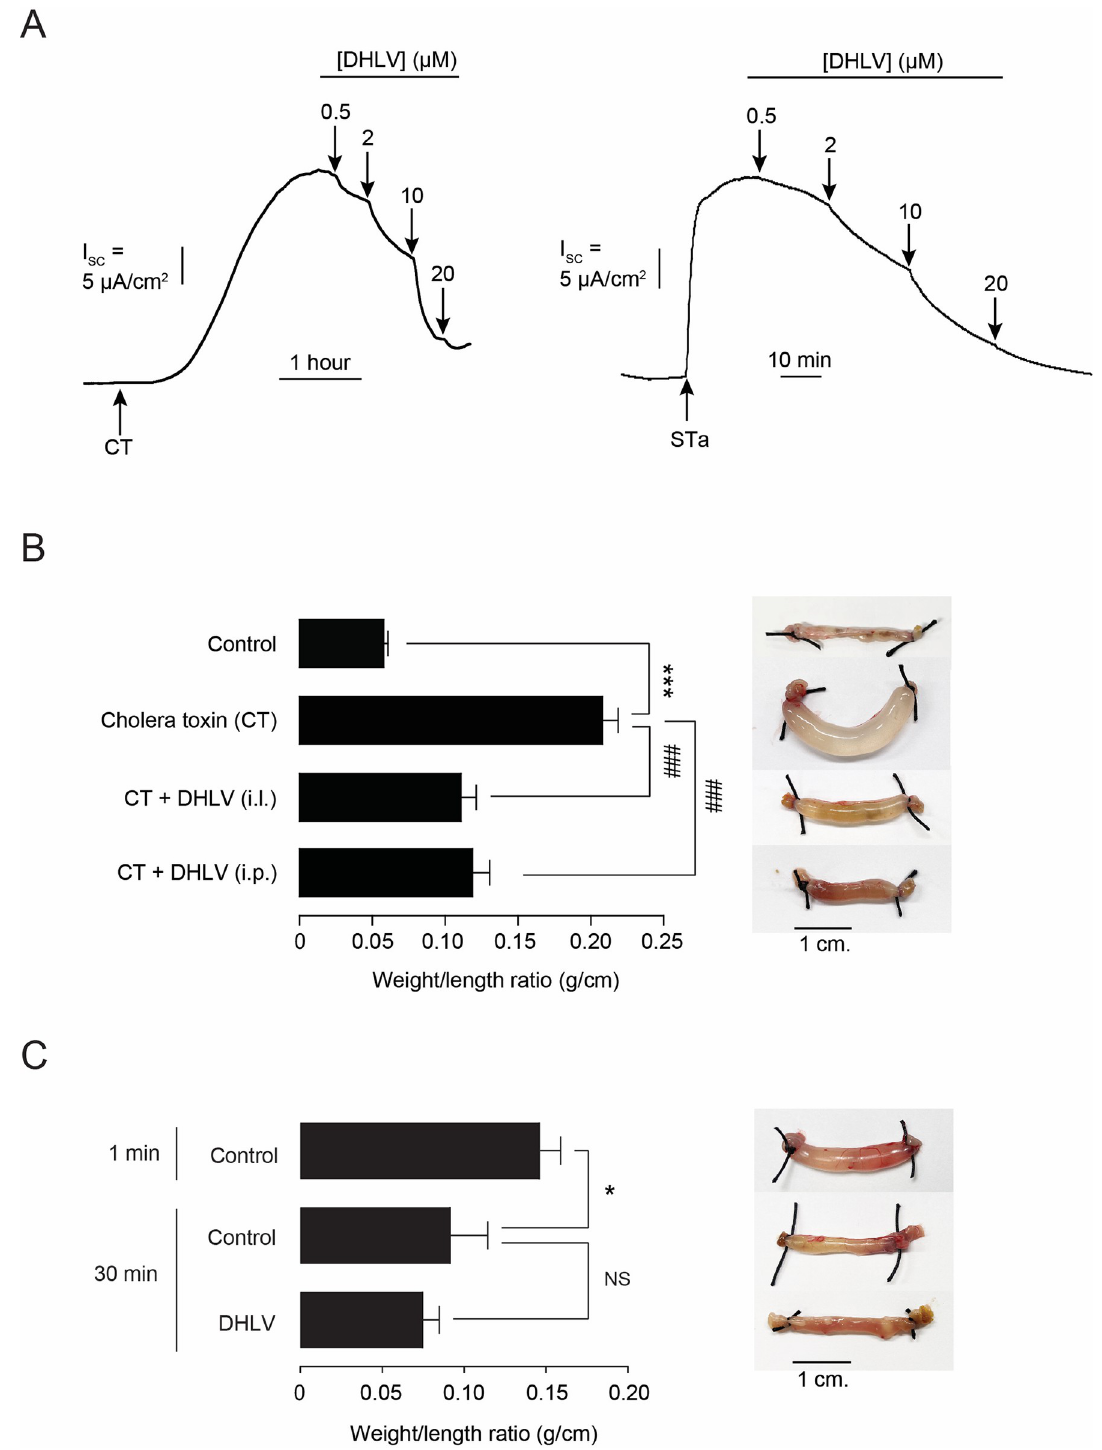
Fig 7. Potential utility of α , β -dehydrolovastatin (DHLV) as an anti-diarrheal agent for secretory diarrheas. (A) Effect of DHLV on cholera toxin (CT)- and heat-stable toxin (STa)-stimulated Cl - secretion in T84 cell monolayers determined by I SC analysis. After apical addition of CT (1 μ g/ml) or STa (100 μ M) to stimulate the increasing of I SC , DHLV was added in both apical and basolateral solution. Representative I SC tracings are shown. (B) Effect of DHLV on CT-induced intestinal fluid secretion determined by ileal closed-loop weight/length ratios. Ileal closed-loops were injected with PBS (control) or PBS containing CT ( μ g/loop) with or without intraluminal